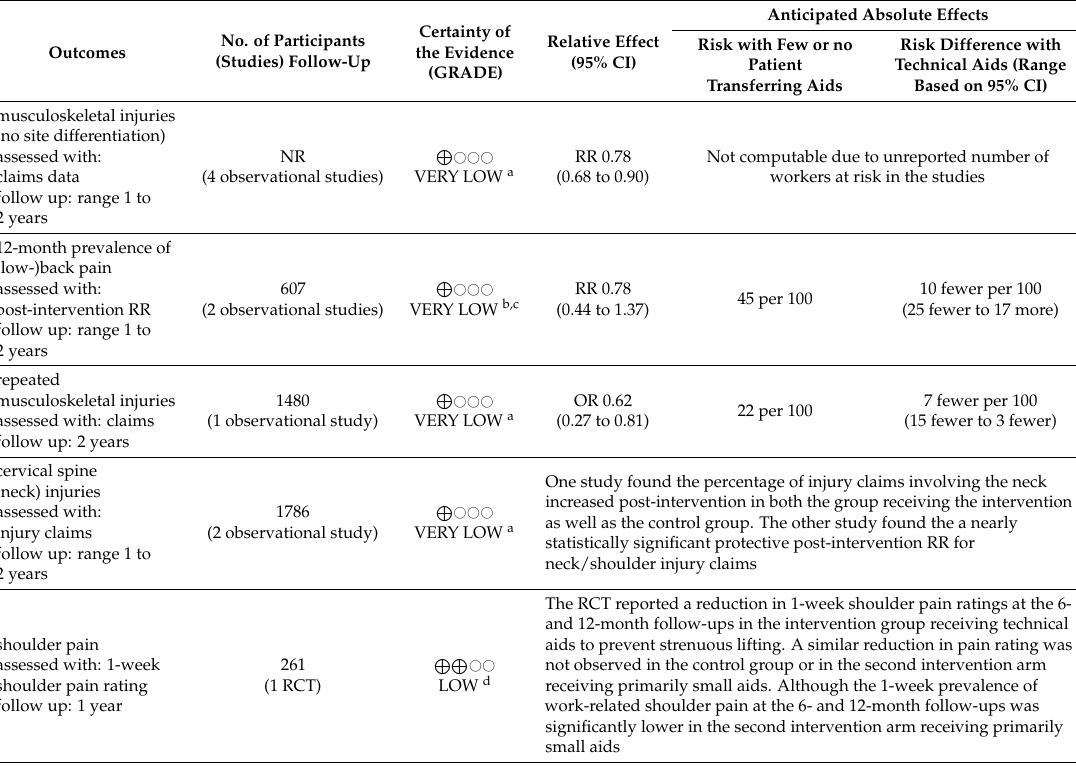
Table 3. Summary of